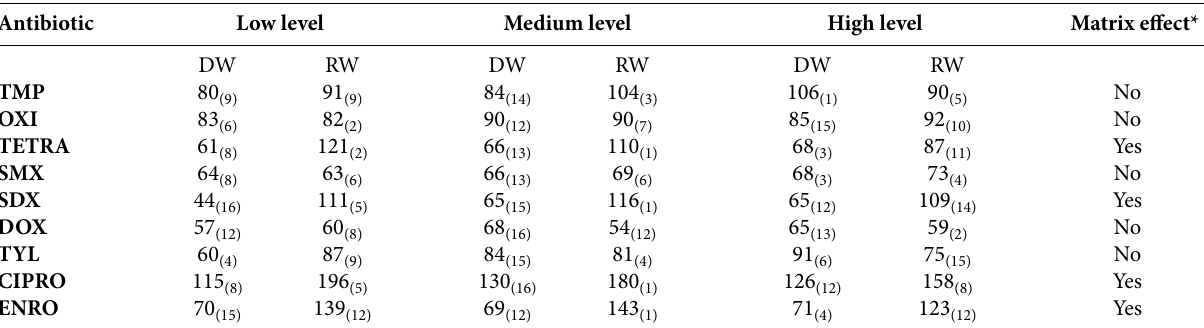
Table 2. Recovery from antibiotics in deionized water (DW) and river water (RW). Data shown as percentage of recovery (%RSD). Antibiotic